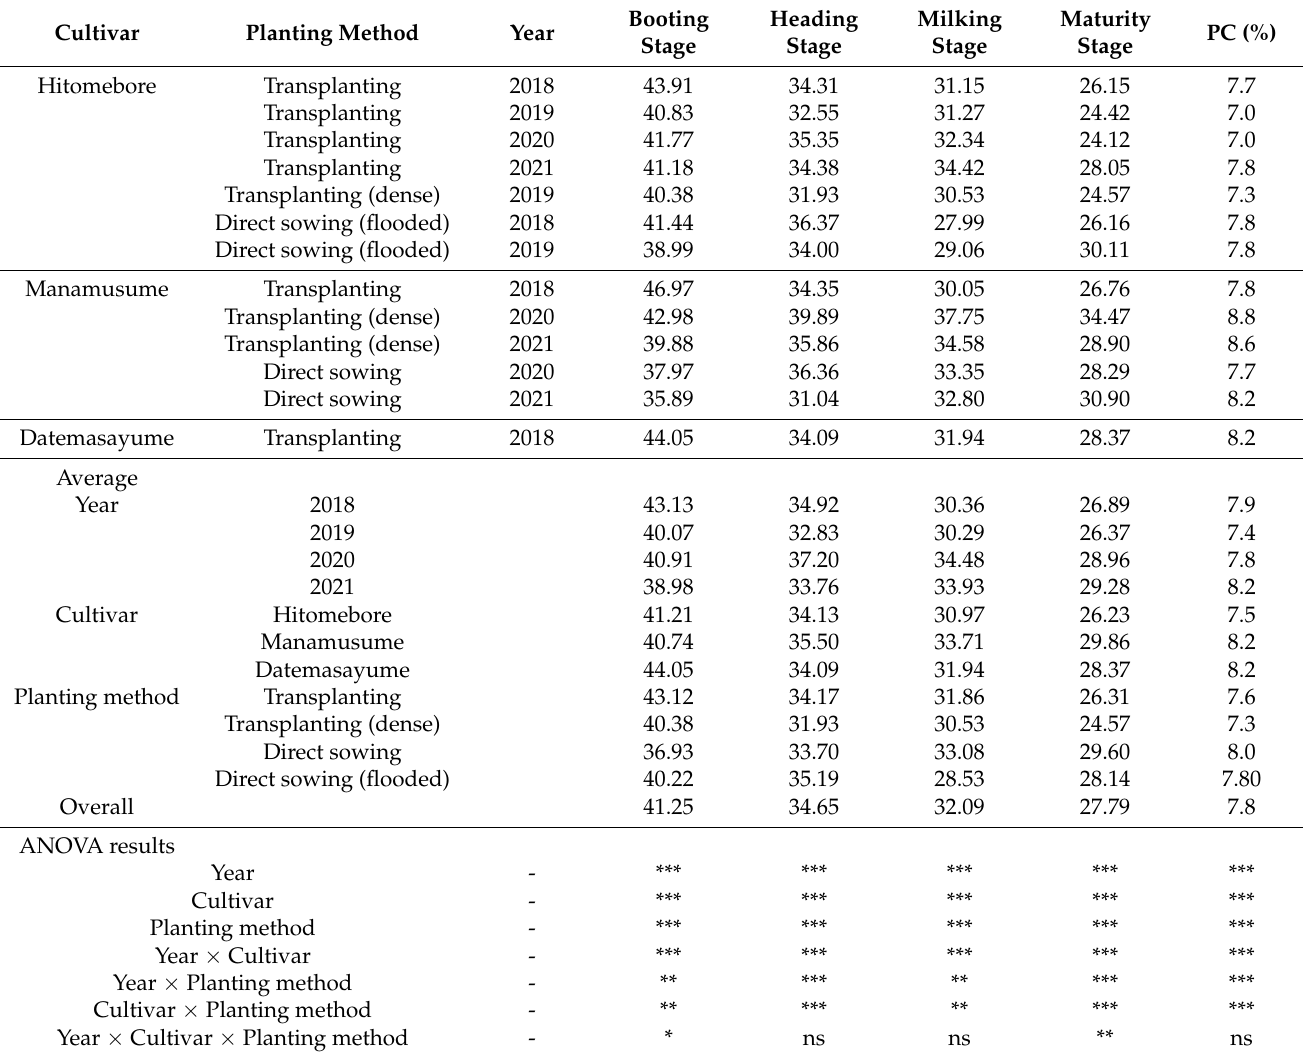
Table 3. Averages and three-way ANOVA results of SPAD at booting stage, heading stage, milking stage, and maturity stage, as well as grain protein content